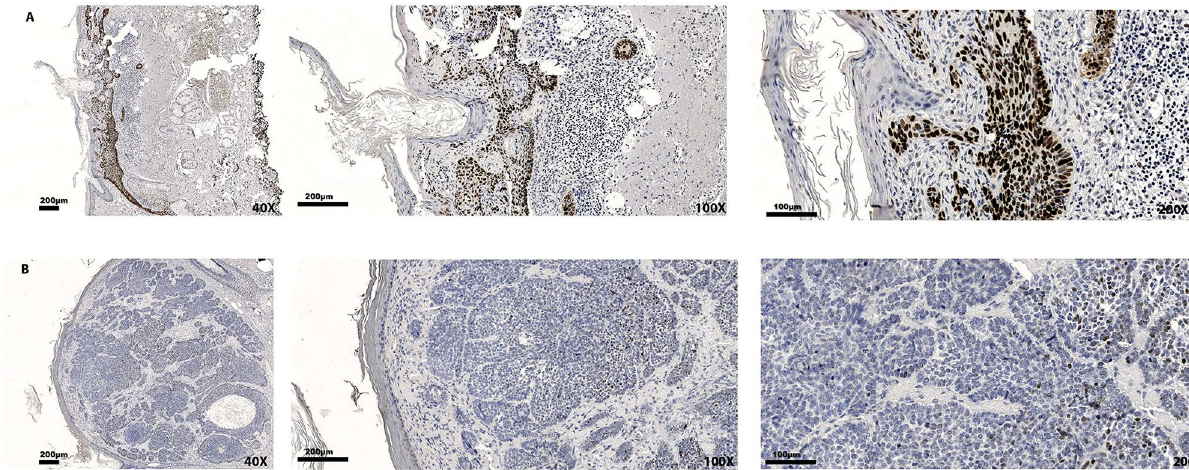
Figure 1. Representative examples of p53 immunoexpression in cBCCs: ( A ) positive (90.6%) expression; ( B ) negative (2.3%)